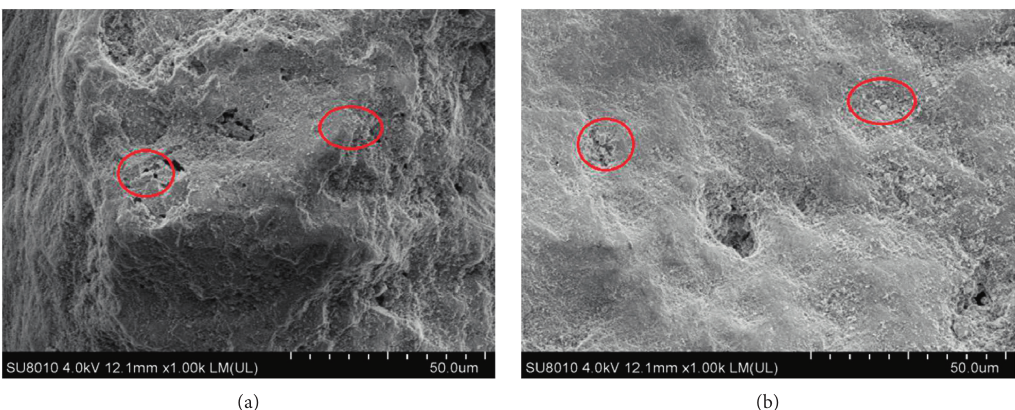
Figure 4: SEM image in a single grain size calcareous sand particle at an amplification factor of 1000: (a) 0.5–0.25mm and (b) 0.25–0mm.